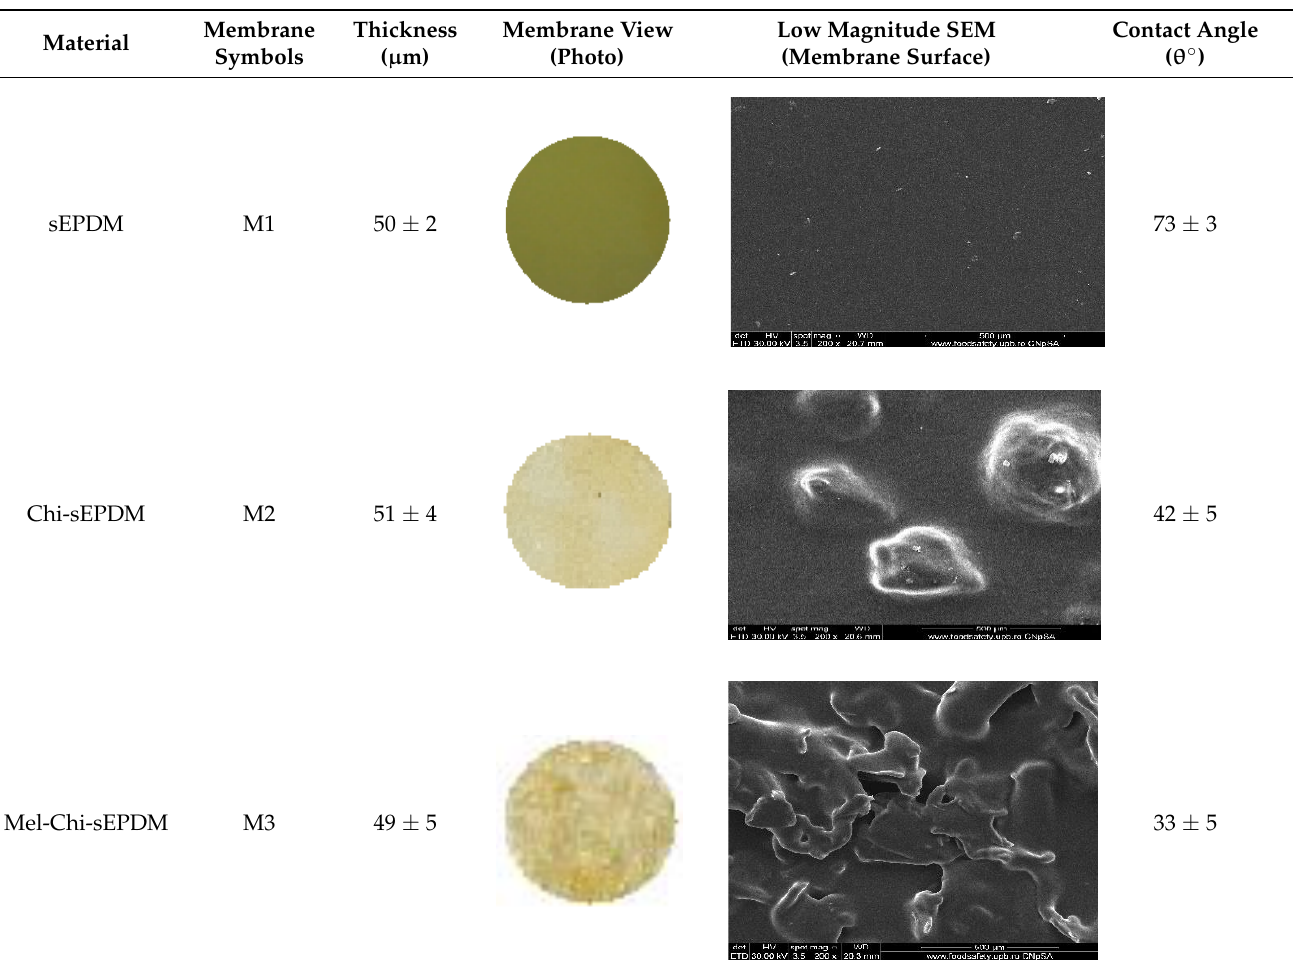
Table 2. The macroscopic characteristics for the obtained membranes.